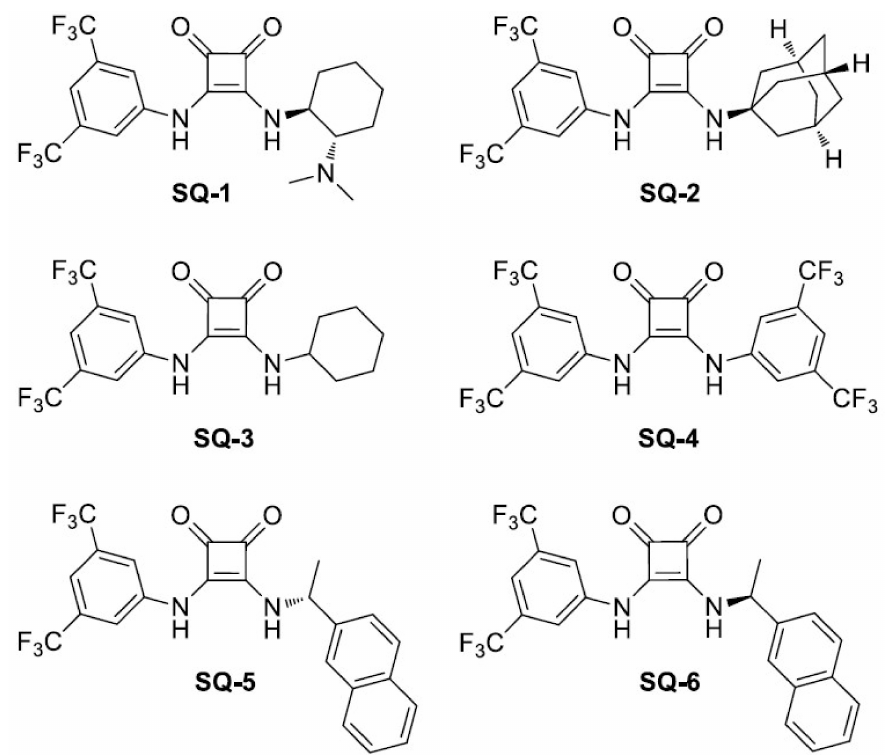
Figure 4. Structures of squaramide-based organocatalysts employed in the work of Jiang et al. [117] for stereoselective ROP of rac-LA. Copyright @ 2022 John Wiley and Sons, License Number: